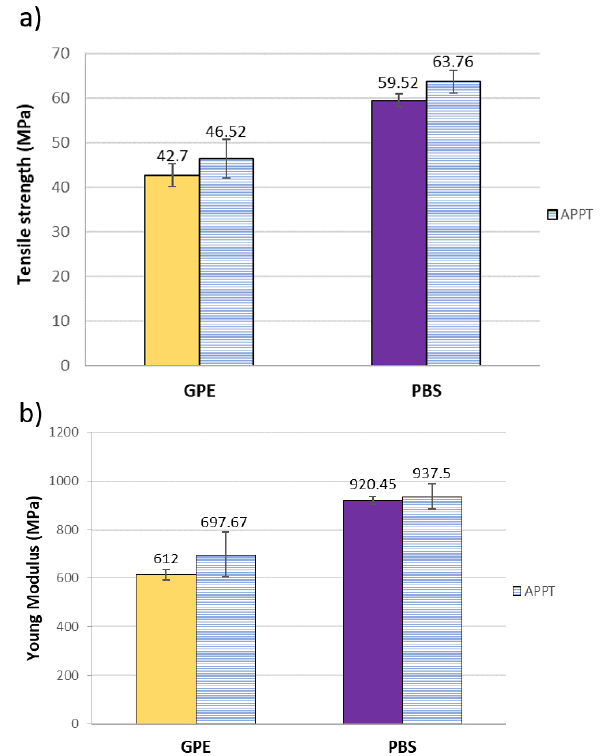
Figure 7. Mechanical properties of GPE and PBS composites. ( a ) Tensile strength and ( b ) Young’s modulus.